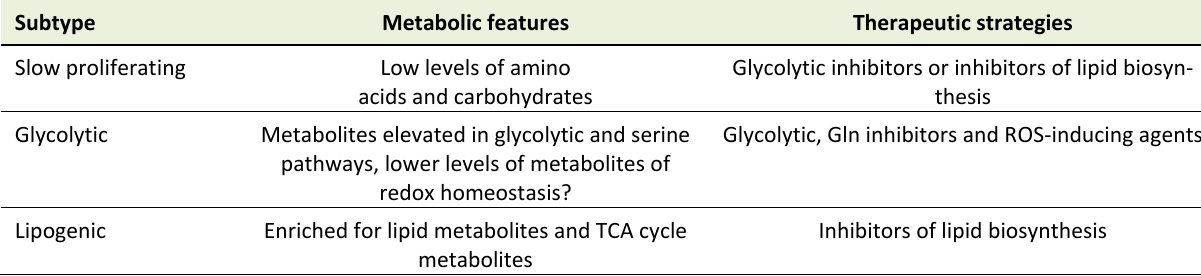
Table 1. Subtypes of PDAC based on metabolic